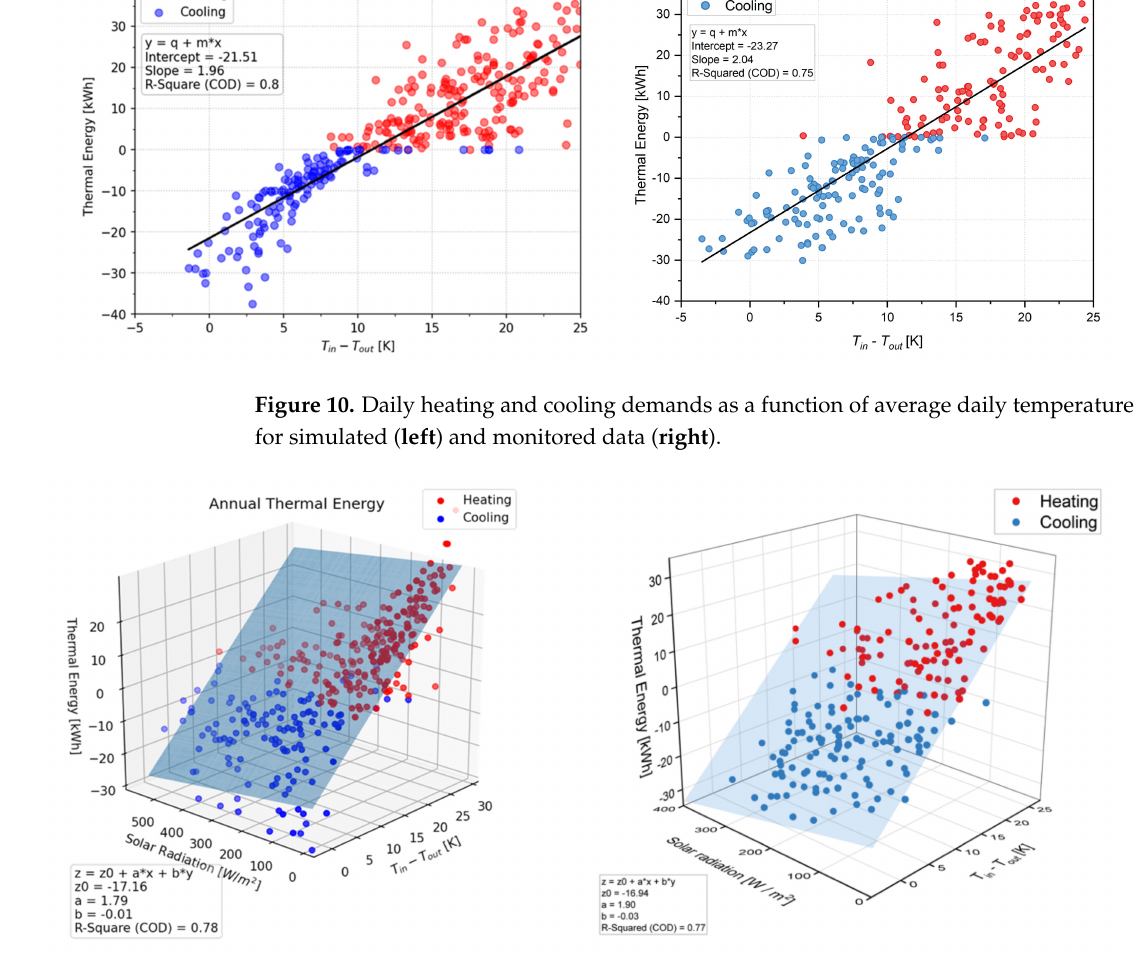
Figure 11. Daily heating and cooling demands as a function of average daily temperature difference and solar radiation on the southwestern facade for simulated ( left ) and monitored data ( right